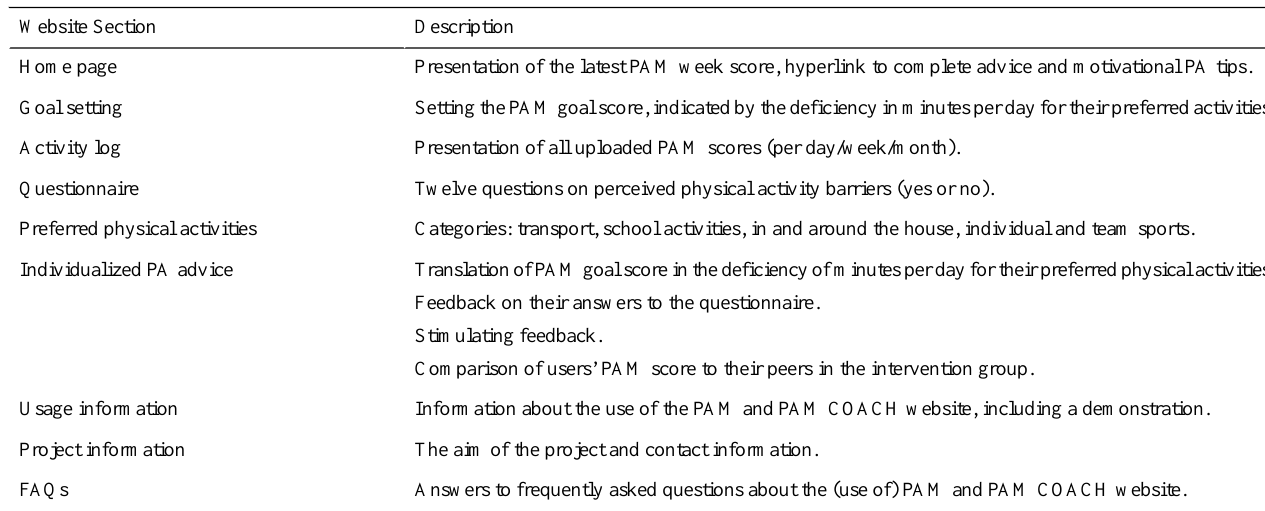
Table 1. Contents of the PAM COACH